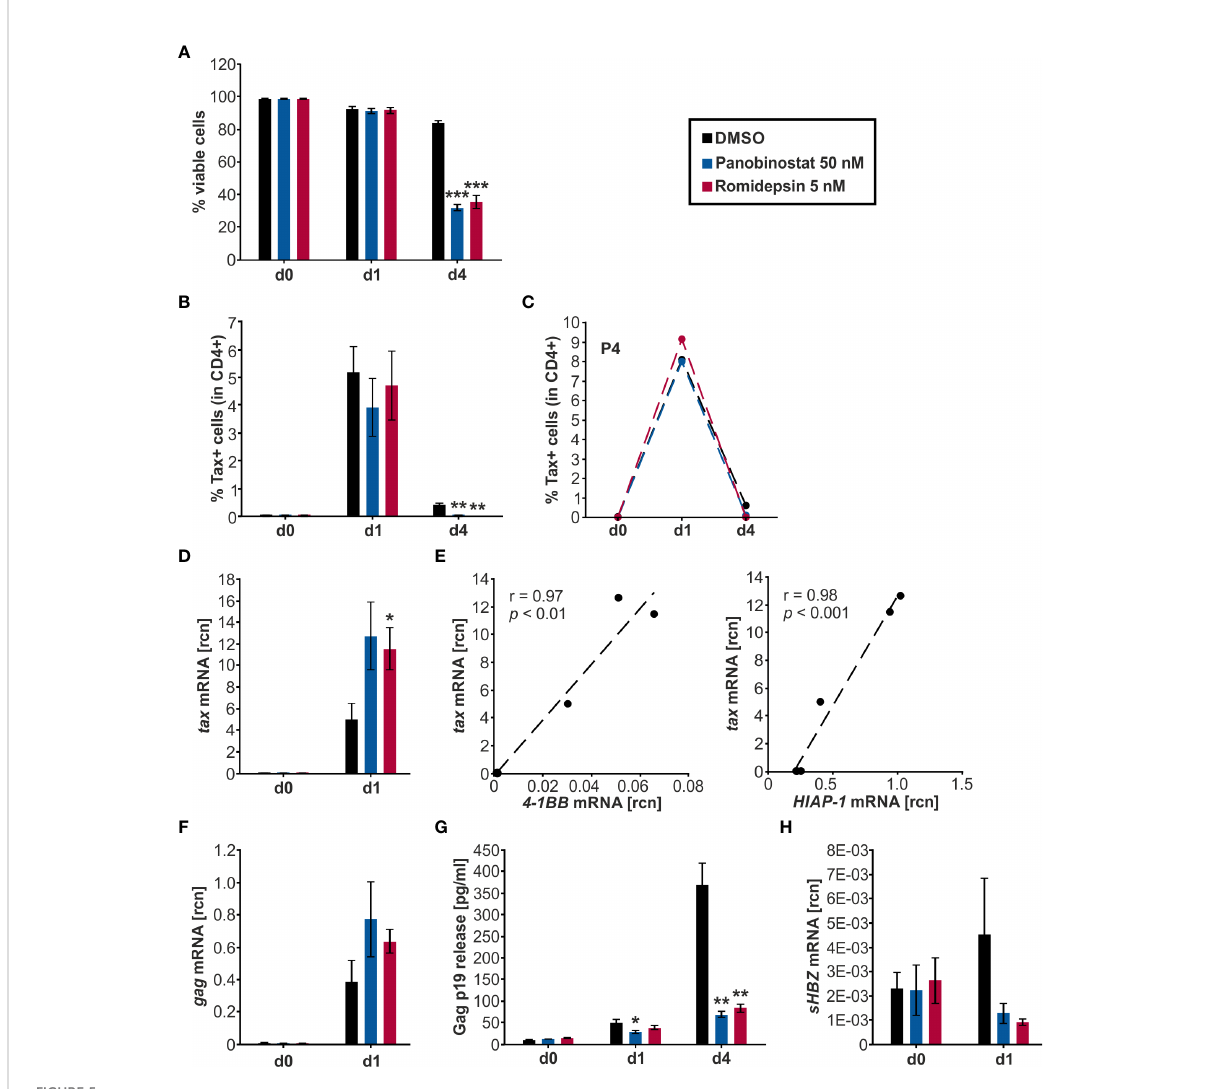
FIGURE 5 Panobinostat and Romidepsin enhance tax transcripts but inconsistently Tax protein. (A – H) CD4 + T-cells isolated from fi ve HTLV-1 infected patients were treated with Panobinostat (50 nM; blue), Romidepsin (5 nM; pink), or the solvent control DMSO (black) on d0. The cultured cells received a second treatment on d2, equivalent to a quarter of the initial treatment of d0. Cells were analyzed via (A – C) fl ow cytometry, (D – F, H) qRT-PCR, and (G) ELISA, on days 0, 1, and 4. (A) Cell viability was determined by fl ow cytometry based on LIVE/DEAD staining. Mean values of the fi ve patient samples (P1-P5) ± SE are depicted, and values were compared to the respective solvent-treated cells (DMSO) using Student ’ s t- test (*** p < 0.001). (B) Intracellular Tax expression was analyzed via fl ow cytometry using the LIVE/DEAD Near-IR Dead Cell Stain Kit, CD4, and Tax (Lt-4 mAB) labeling (gating strategy: Supplementary Figure 5A). The mean percentage of intracellular Tax protein expression of the fi ve patient samples ± SE was compared to DMSO treatment using Student ’ s t-test (** p < 0.01). (C) The individual frequency of Tax expression of patient 4 (P4) is plotted. (D) Mean rcn of tax , normalized to those of the housekeeping gene b -Actin , of the fi ve patients ± SE were compared using Student ’ s t-test (* p < 0.05 relative to DMSO). (E) Mean rcn of tax and Tax-target genes 4-1BB and HIAP-1 , normalized to the housekeeping gene b -Actin , were correlated and subjected to Pearson correlation analysis (Pearson correlation coef fi cient r = 0.97, and r = 0.98 respectively, p = 1.18E-03, and p = 2.43E-04 respectively). (F) Mean rcn of g ag , normalized to those of the housekeeping gene b -Actin , of the fi ve patients ± SE were compared using Student ’ s t-test (all p > 0.05 relative to DMSO). (G) The release of Gag p19 was assessed via ELISA. The mean of the fi ve patient samples of the absolute Gag p19 concentration ± SE is represented and was compared using Student ’ s t-test (* p < 0.05; ** p < 0.01, relative to DMSO). (H) Mean rcn of sHBZ , normalized to those of the housekeeping gene b -Actin , of the fi ve patients ± SE were compared using Student ’ s t-test (all p > 0.05 relative to